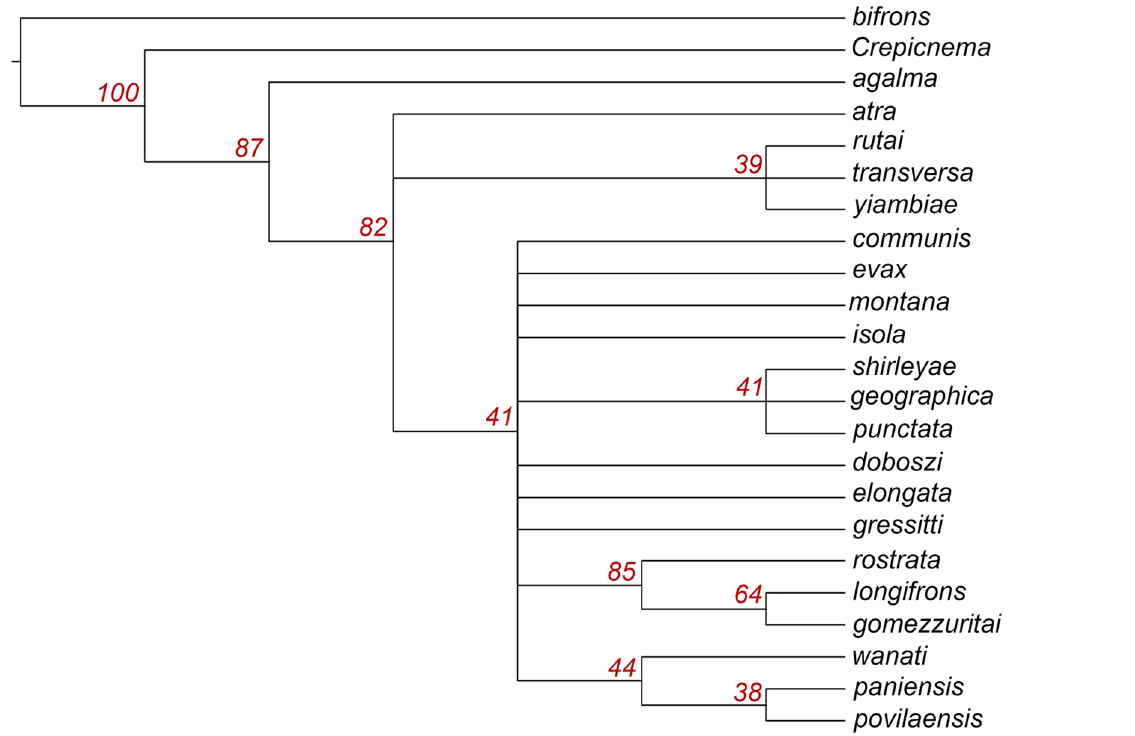
Fig. 16. Strict consensus tree with jackknife values (see